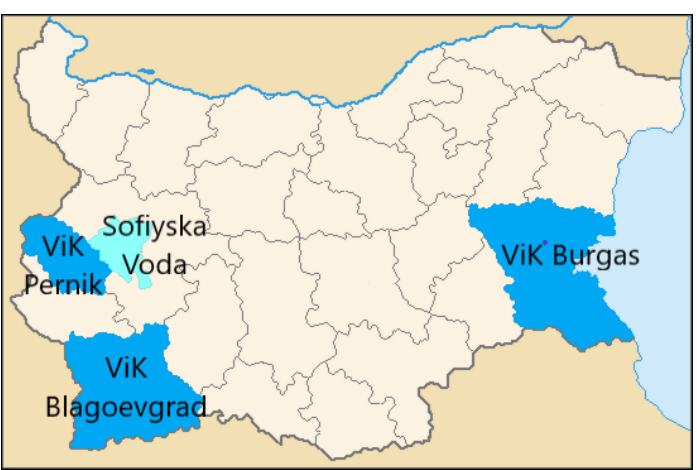
Figure 2. Location of the selected WSSOs in Bulgaria. Table 1. Main characteristics of the selected WSSOs (WSN—water supply network, SN—sewer